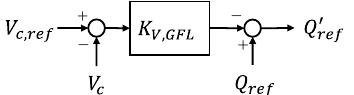
Figure 7. Controller model of the grid-following virtual inertia control (VI-GFL) used in a part of the simulation in Step 3.